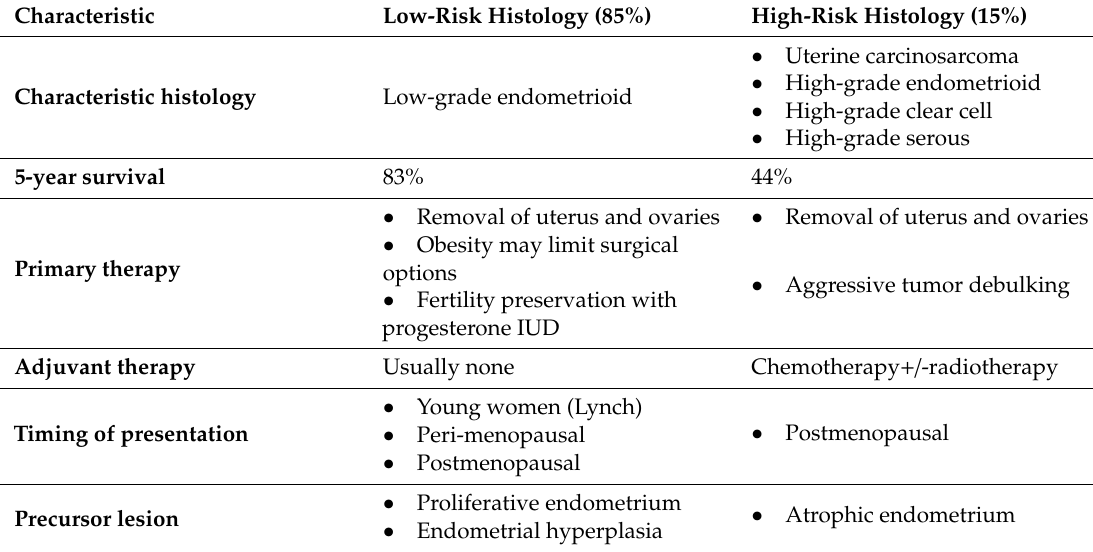
Table 1. General clinical